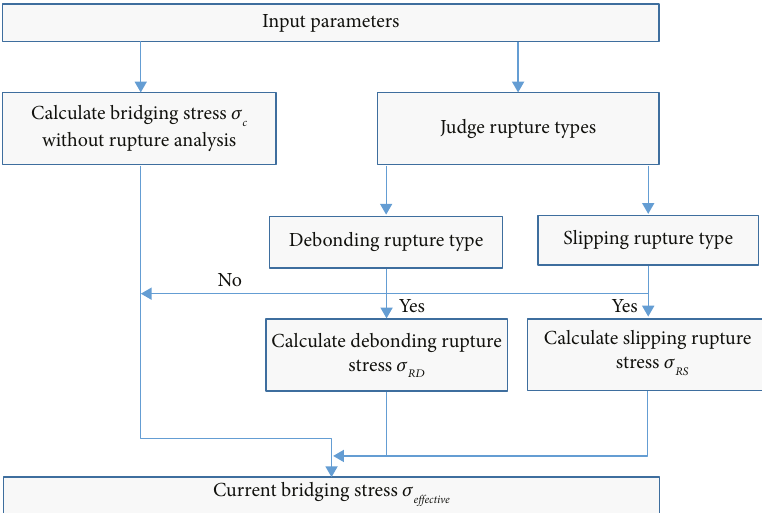
Figure 13: A flowchart for the current bridging model.